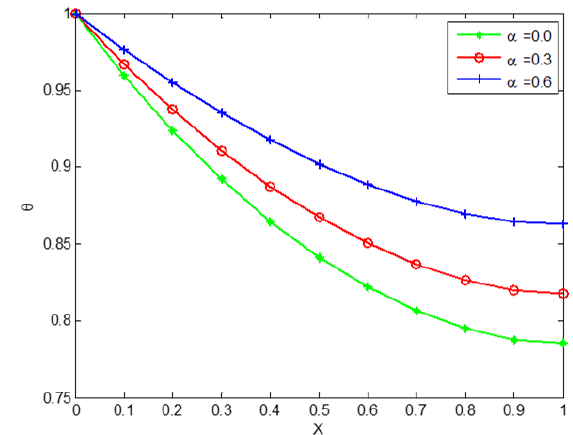
Figure 8. Effect of different value of surface emissivity on temperature distribution of trapezoidal silicon nitride porous fin